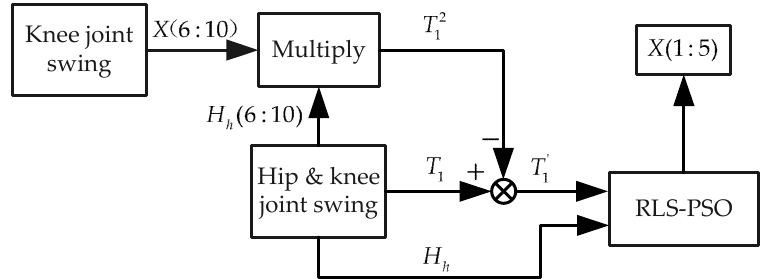
Figure 5. Flowchart of segmental identification strategy.